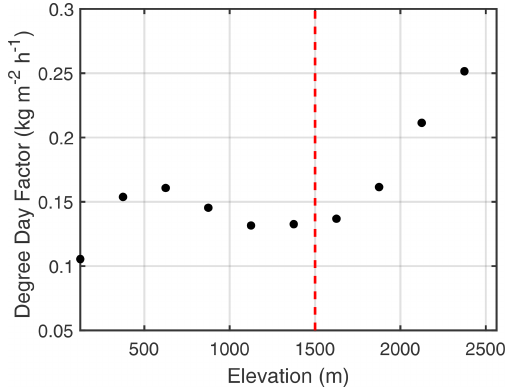
Figure 8. Mean degree-day factors over the Greenland Ice Sheet binned at 250m elevation intervals for a temperature threshold, T 0 , of 270.25K. We assume that degree-day factors above the verti- cal dashed red line at 1500m are non-physical (i.e., too large). For all elevations greater than 1500m, we apply a maximum degree- day factor equal to the mean within the 1250–1500m elevation bin (0.13kgm − 2 h − 1 K − 1